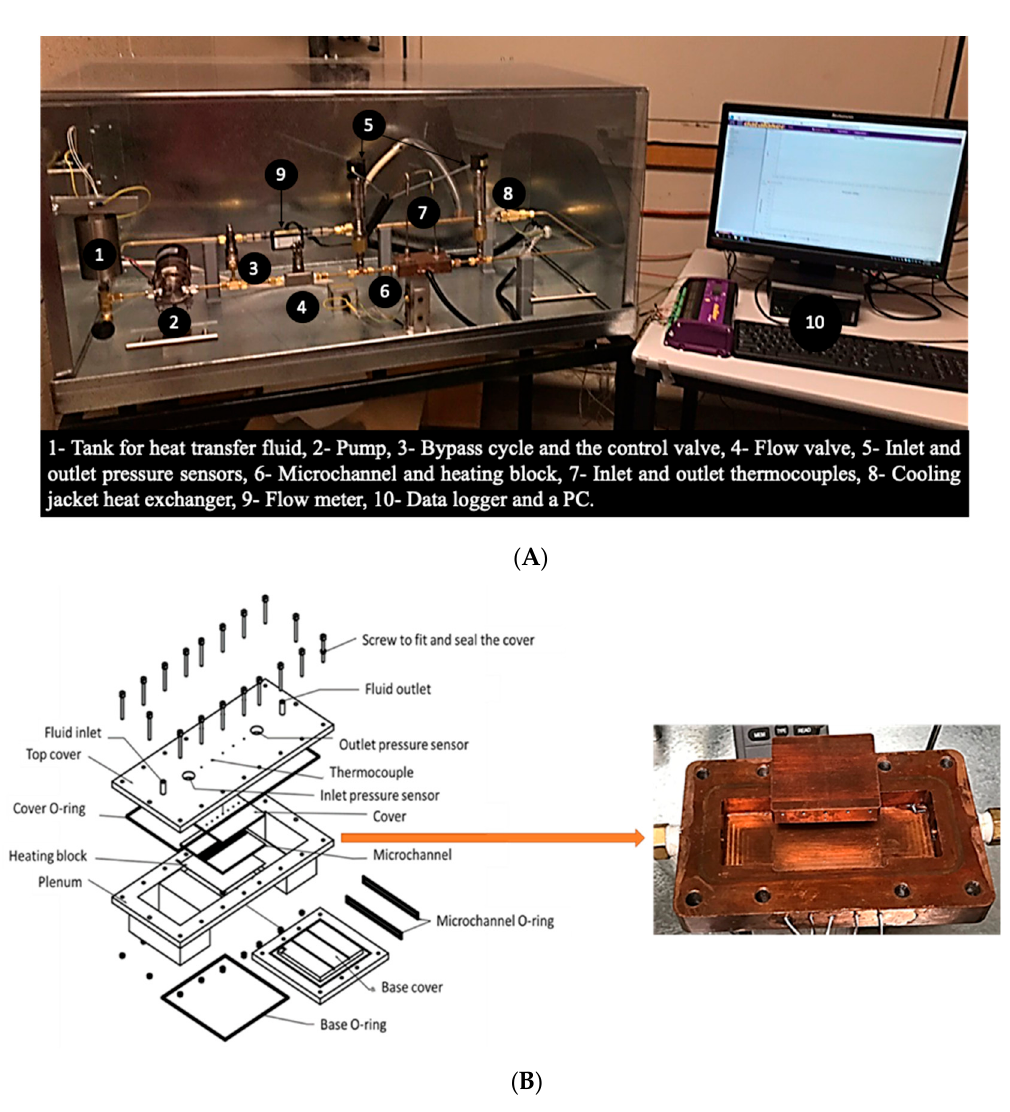
Figure 1. Experimental device used in this work, ( A ) image of the test rig, ( B ) Image of the micro-channel and its schematic diagram.